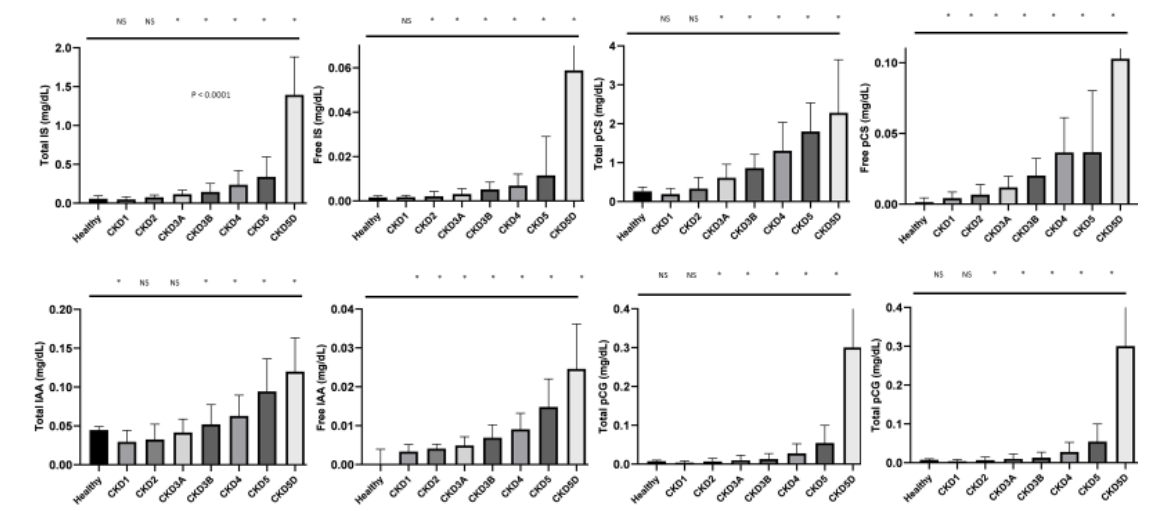
Figure 3. Levels of uremic toxins over the different stages of CKD. * p < 0.05 vs healthy. Abbreviations: NS, non-significant;